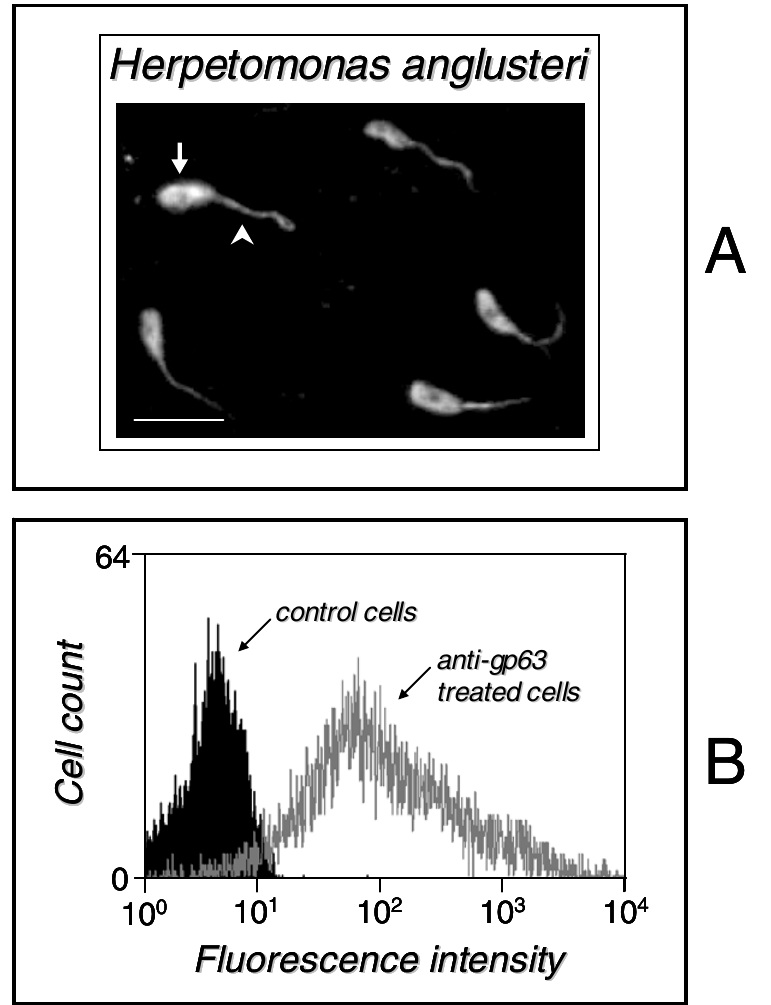
Fig. 6 – Binding of anti-gp63 antibodies (Ilg et al. 1993) to the cell surface of Herpetomnas anglusteri promastigote cells. The fixed parasites were incubated with a 1:250 dilution of rabbit anti-gp63 antibody ( anti - gp63 treated cells ) or rabbit pre-immune serum ( control cells ), and then incubated for an additional hour with a 1:250 dilution of fluorescein isothiocyanate (FITC)-labeled goat anti- rabbit IgG. The cells were then observed in confocal fluorescence microscopy ( A ) or analyzed by flow cytometry ( B ). The experiments were performed as described elsewhere (d’Avila-Levy et al. 2006a). The bar represents 10 µ m. Note in A an intense fluorescence signal for gp63 on both cellular body (arrow) and flagellum